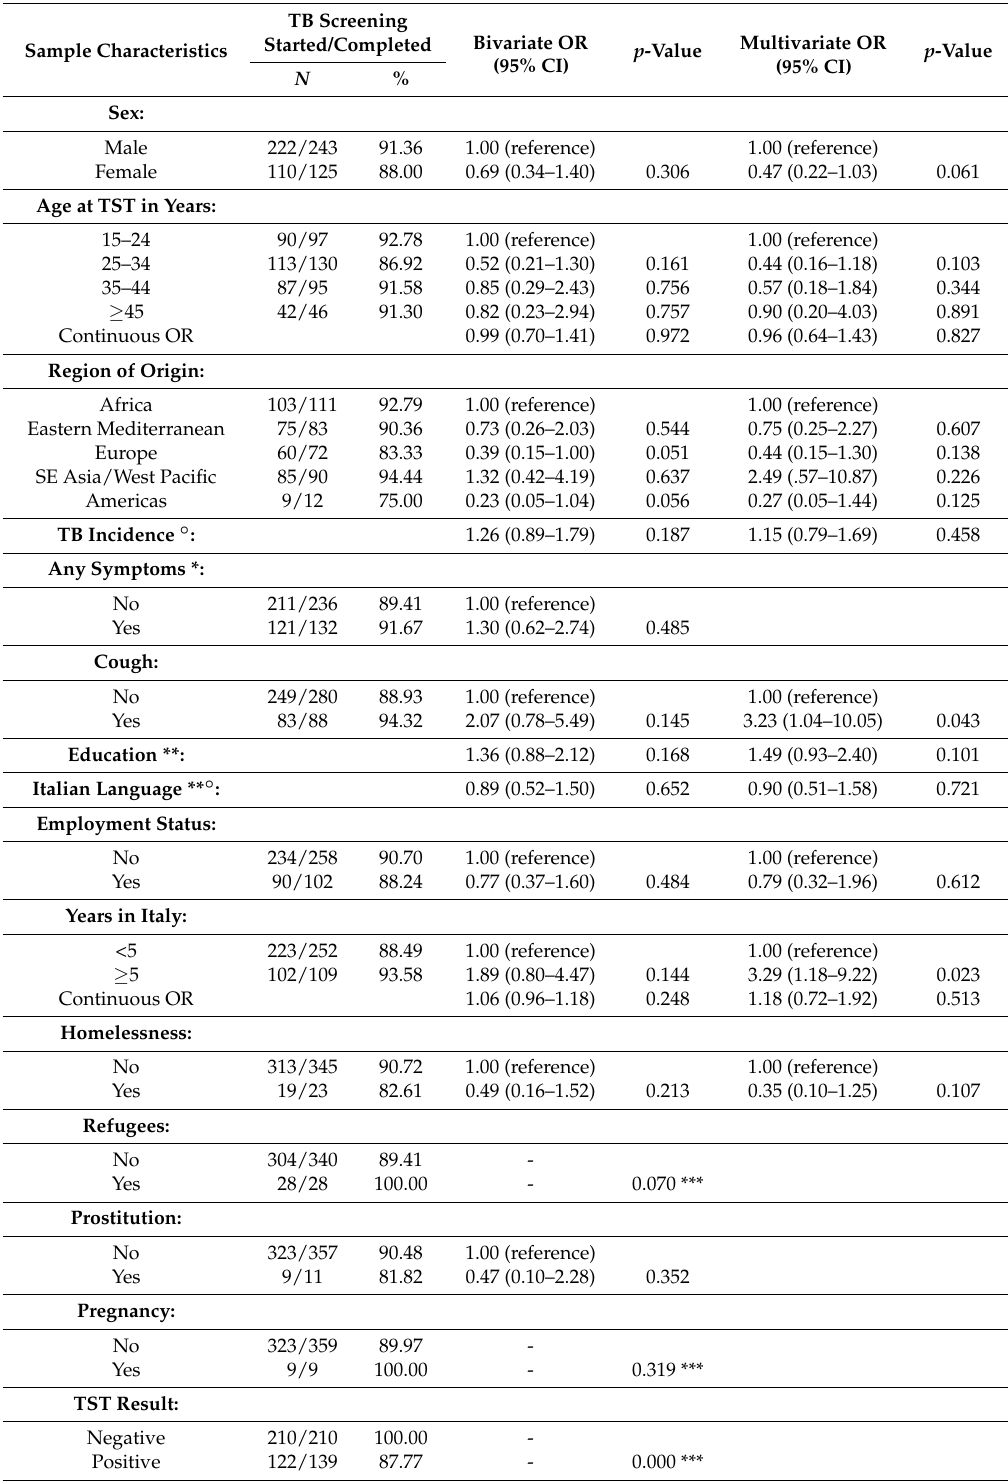
Table 2. Association between selected characteristics and compliance with screening for active tuberculosis